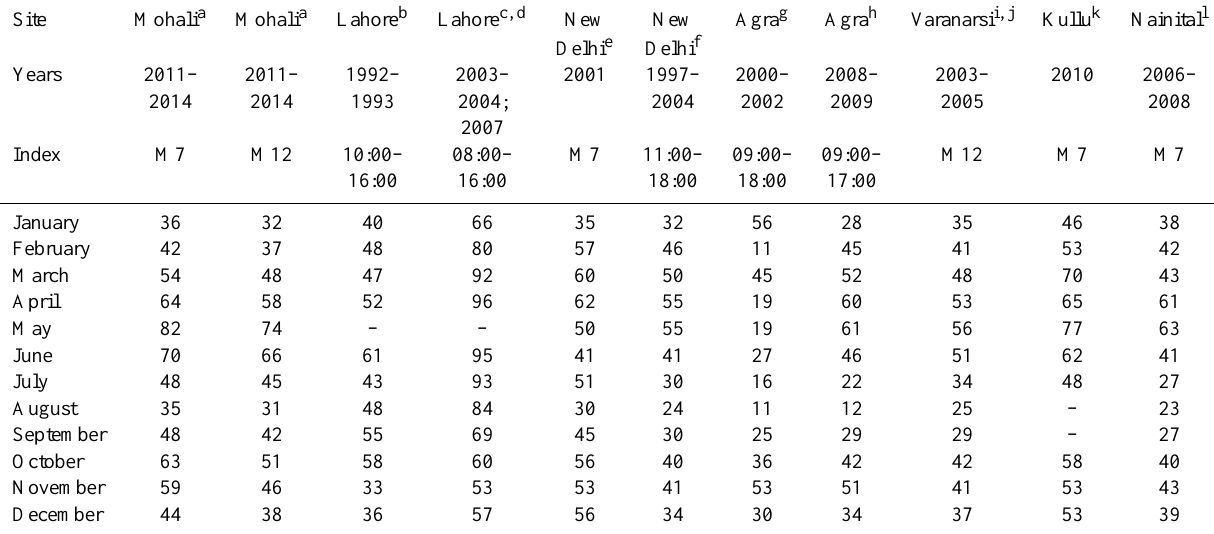
Table 4. Comparison of the average monthly ozone exposure indices observed at a suburban site in Mohali with measurements at other urban (superscript letters a–h) and suburban (superscript i and j) sites in the IGP and nearby remote mountain (superscript l) and suburban valley (superscript k) sites indicated in Fig. 1.